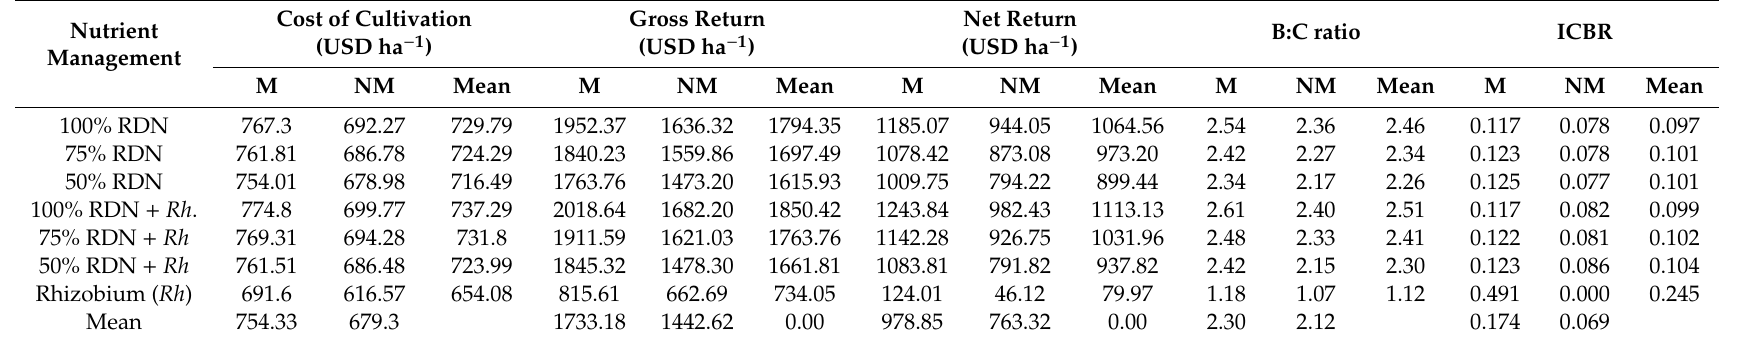
Table 9. E ff ect of soil covering and nutrient management on economics of summer peanut in 2015–2016.